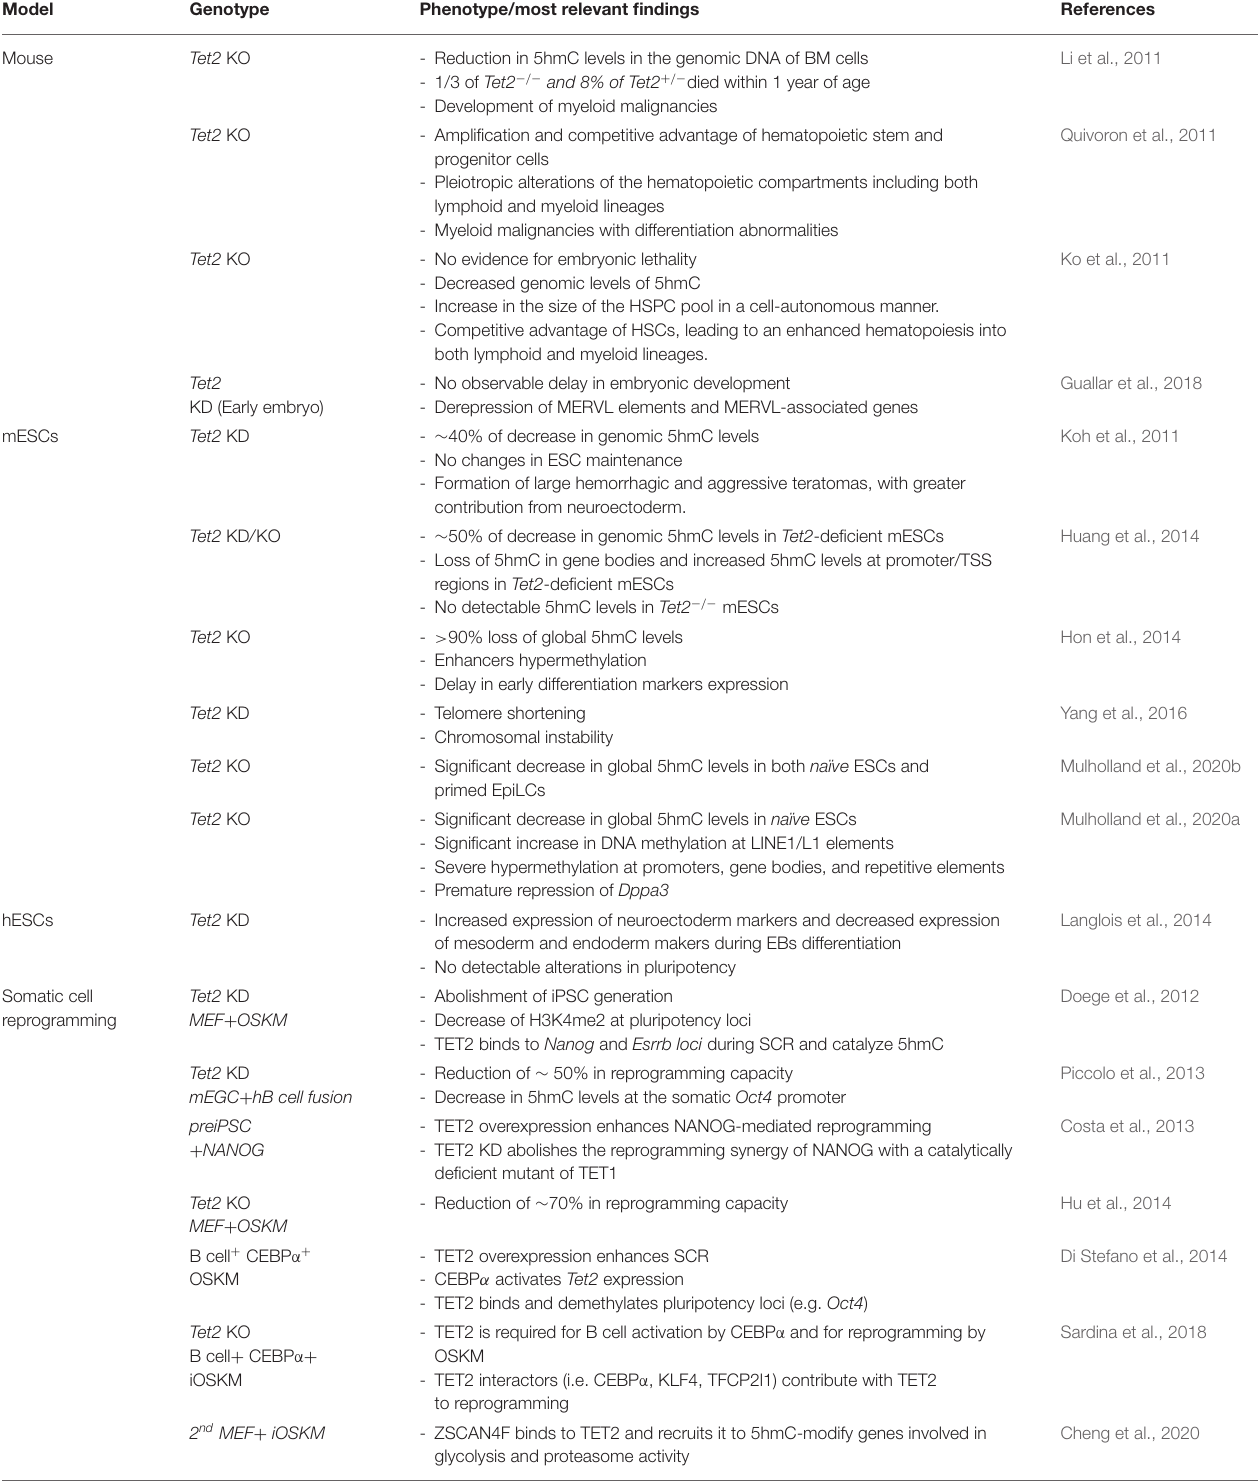
TABLE 1 | Overview of TET2 studies deciphering its role and functions in mouse, murine embryonic stem cells (mESCs), human embryonic stem cells (hESCs) and during somatic cell reprogramming.